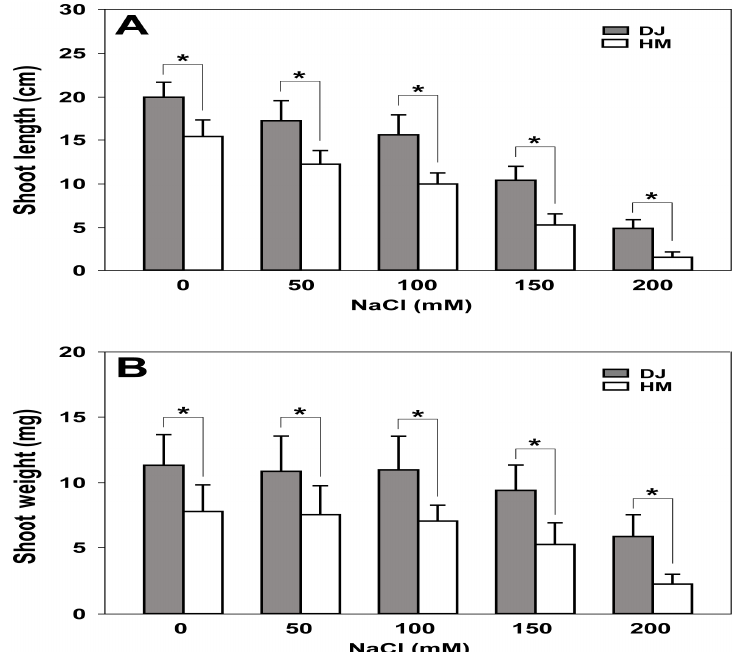
Figure 5. Osfuct mutant sensitivity to salt stress. Effect of salt stress on growth of rice seedlings. Seedlings of the Dongjin (DJ) and mutant lines (HM) were exposed to a nutrient solution containing 0–200 mM NaCl. After 3 weeks, individual leaves were separated and shoot length ( A ) and weight were measured ( B ). Data are mean ± SD ( n = 15). Asterisk indicates a significant difference compared with wild type (* p < 0.05 by t -test). Error bars show standard deviation.